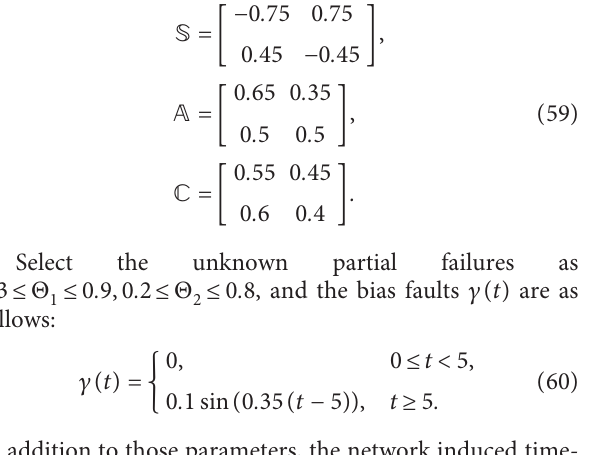
Figure 4: Modes evolution of the NSUSVs, controller, and actuator.